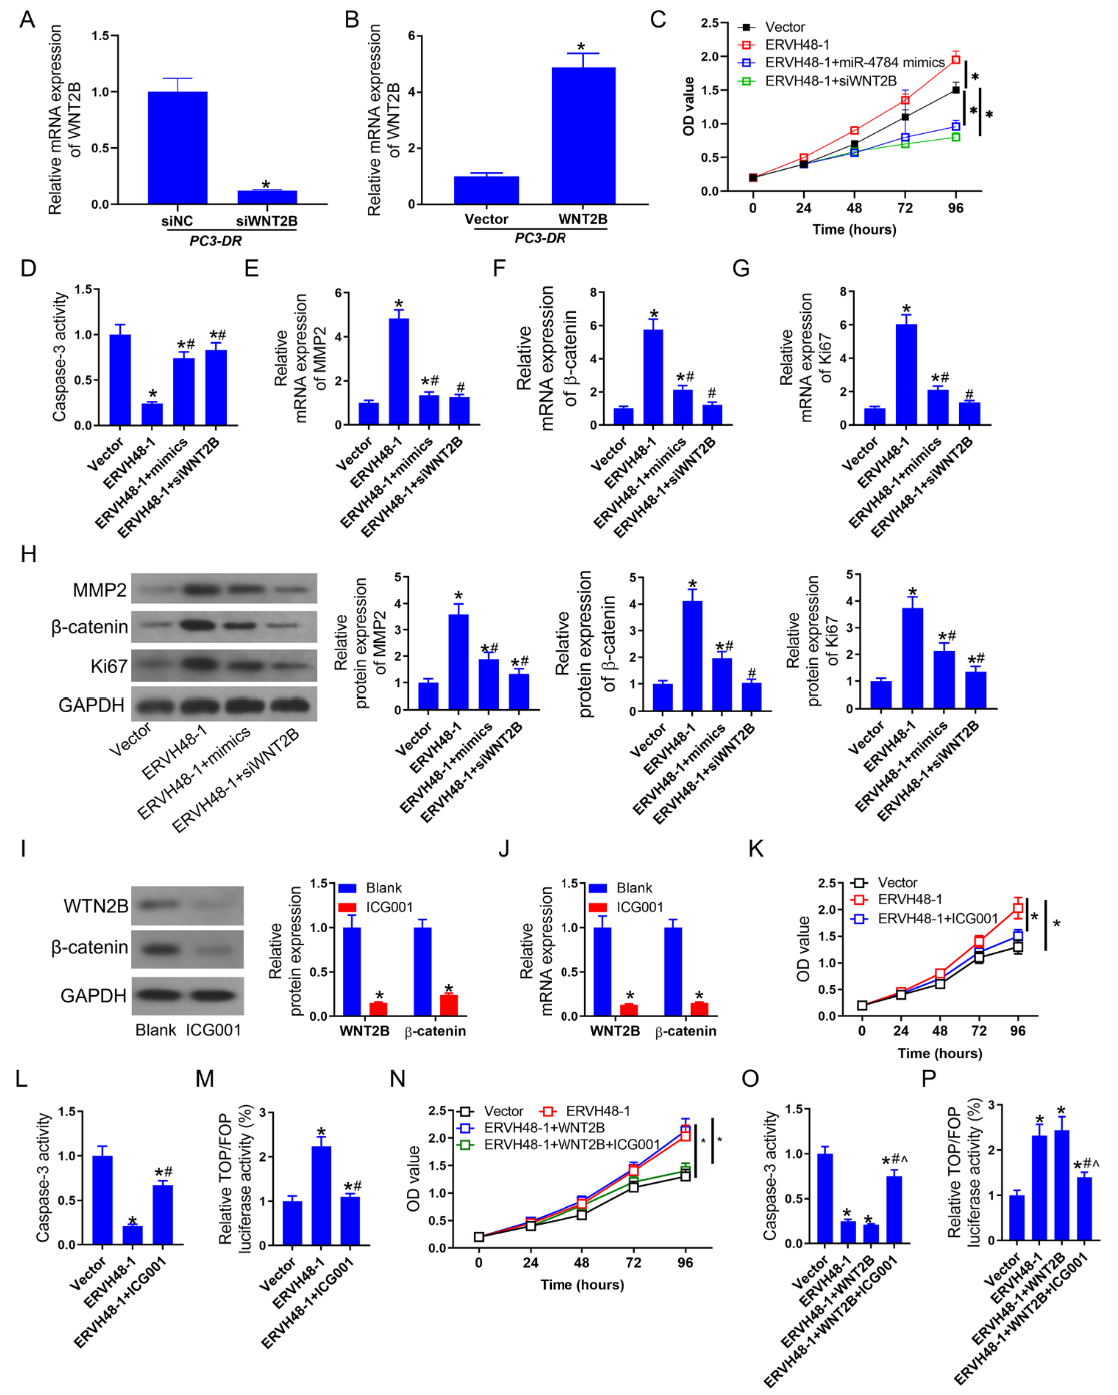
Figure 9. ERVH48-1 activates the Wnt/ β -catenin signaling pathway via the miR-4784/WNT2B axis to regulate cell viability and apoptosis. ( A , B ) RT-PCR analysis of WNT2B expression. ( C ) CCK8 assays were used to detect cell viability. ( D ) Detection of caspase-3 activity. RT-PCR ( E – G ) and Western blot ( H ) assays were used to detect the expression of MMP2, β -catenin, and Ki67. Western blot ( I ) and RT-PCR ( J ) assays were used to detect the expression of WNT2B and β -catenin in ICG001-treated cells. ( K , N ) CCK8 assays were used to detect cell viability. ( L , O ) Detection of caspase-3 activity. ( M , P ) Detection of TOP/FOP transcriptional activity. * p < 0.05, # p < 0.05, and ˆ p < 0.05. All experiments were repeated three times.